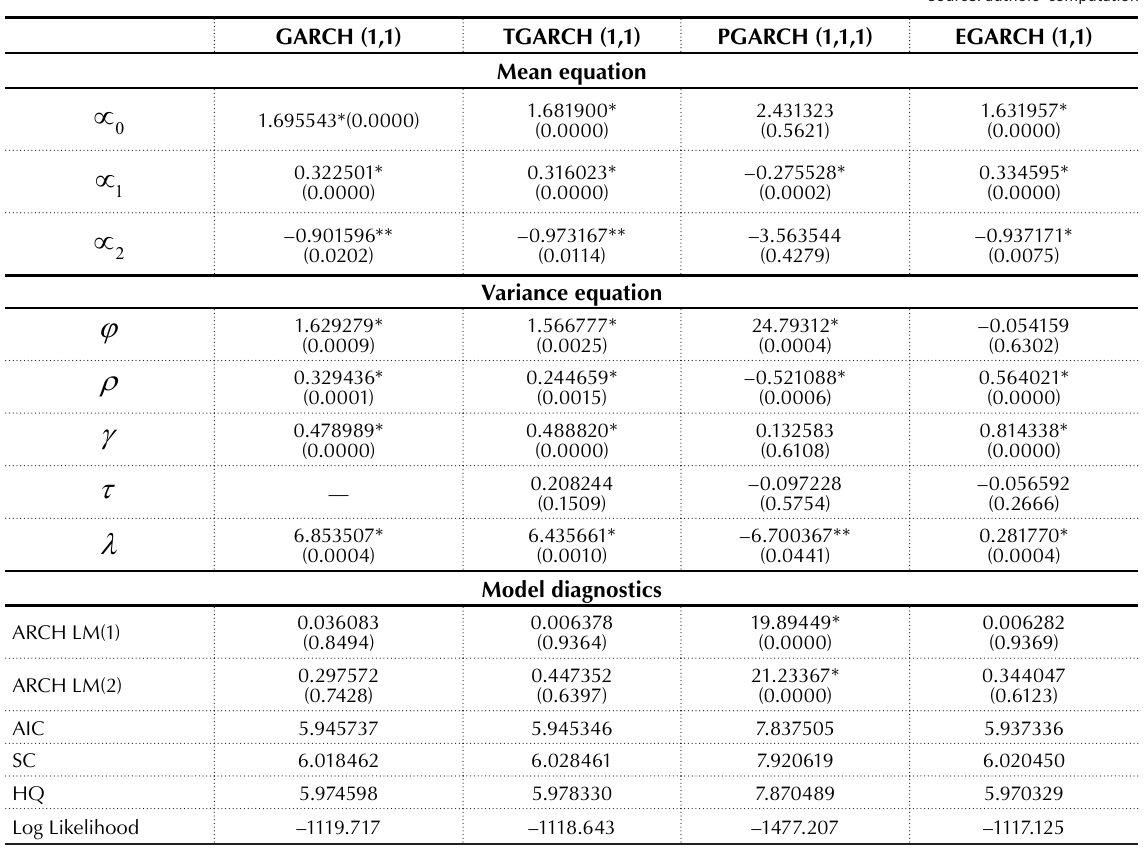
Table 3. GARCH models estimation